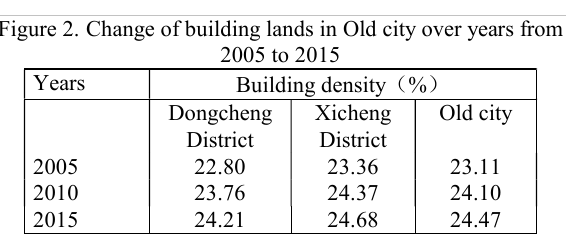
extracted build-up lands in Beijing old city, the area of build-up 5 years interval. Based on equations (1-3), the values of BDGR, old city in Beijing(Figure 4). Overall, compared to BDGR and PGR, BDGRPGR showed little change between 2005 and